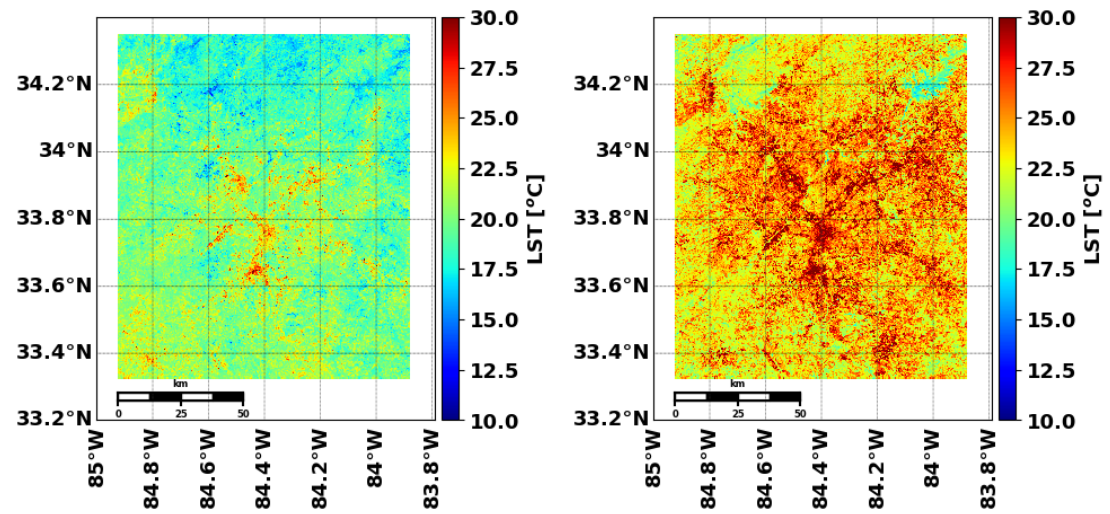
Figure 3. Maps of the LST annual median for 1994 ( left ) and 2010 ( right ), computed through CE over all the Landsat images available for the considered year within the ROI of Atlanta MA. The pixel size is 30 m, as the raw Landsat images from which they derive.